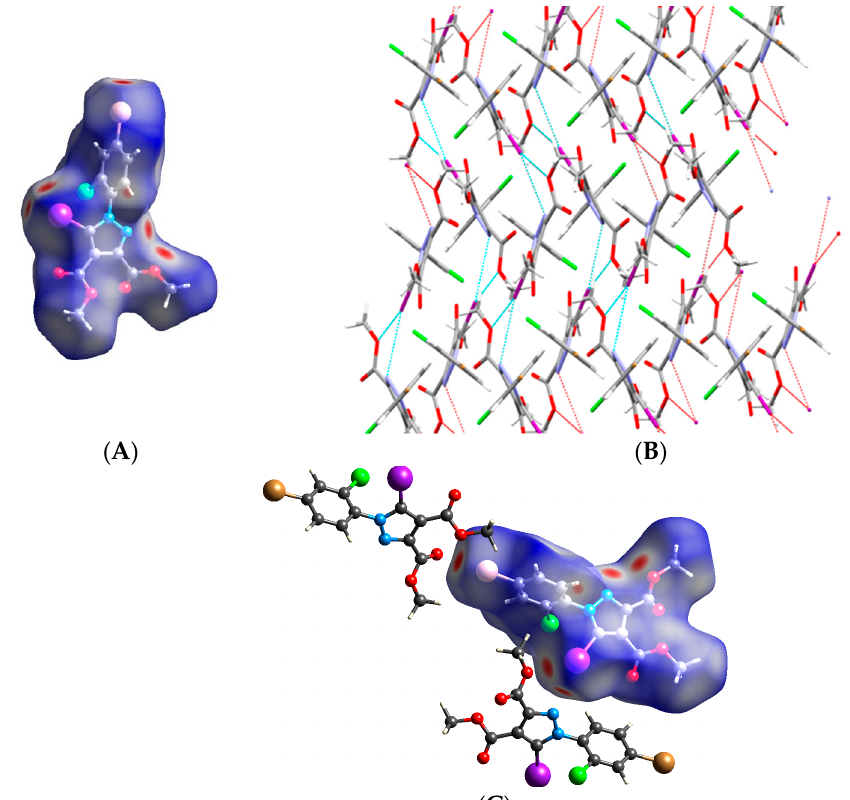
Figure 18. Hirshfeld surface of compound 6 showing relevant halogen contacts: ( A ) The red spots corresponding to the bifurcated I ⋯ O and I ⋯ N contacts; ( B ) Cristal packing presenting the bifurcated iodine bond; ( C ) Hirshfeld surface presenting both iodine and bromine atoms involved in halogen contacts. Halogen bond parameters: C-I bond length: 2.062 Å; I ⋯ O distance: 3.230 Å; I ⋯ N distance: 3.280 Å; sum of the vdW radii: 3.5 Å [58] (I ⋯ O); sum of the vdW radii: 3.53 Å [58] (I ⋯ N); ∠ C-I ⋯ O: 146.1° ; ∠ C-I ⋯ N: 162.2° . Halogen bond parameters: C-Br bond length: 1.897 Å; Br ⋯ O distance: 3.048 Å; sum of the vdW radii: 3.37 Å [58]; ∠ C-Br ⋯ O: 172.4° .